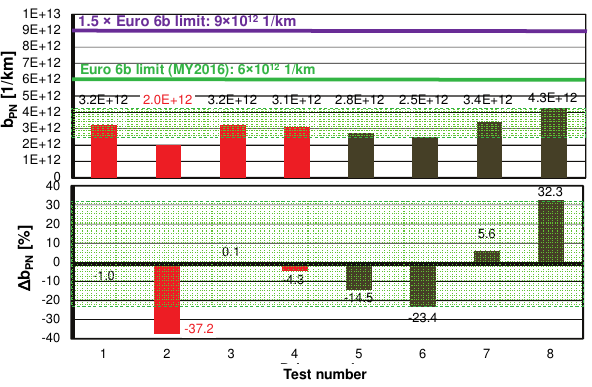
Fig. 11. Particle emission number and relative error for all